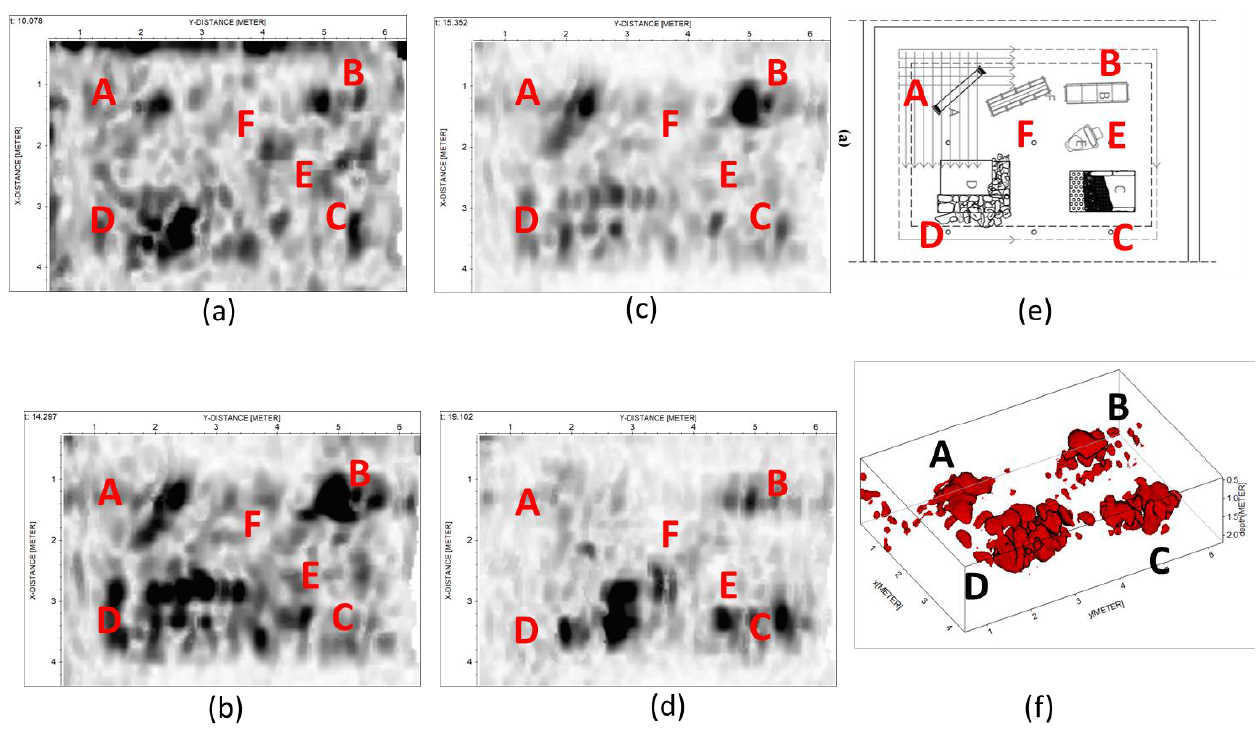
Figure 7. Time-slices at the depths of 0.25 m ( a ), 0.45 m ( b ), 0.70 m ( c ), and 1.00 m ( d ) with a water table at a depth of 1.00 m (WL2); ( f ) the 3D iso-amplitude volumes obtained selecting only the highest reflections; ( e ) the plane of the test site .